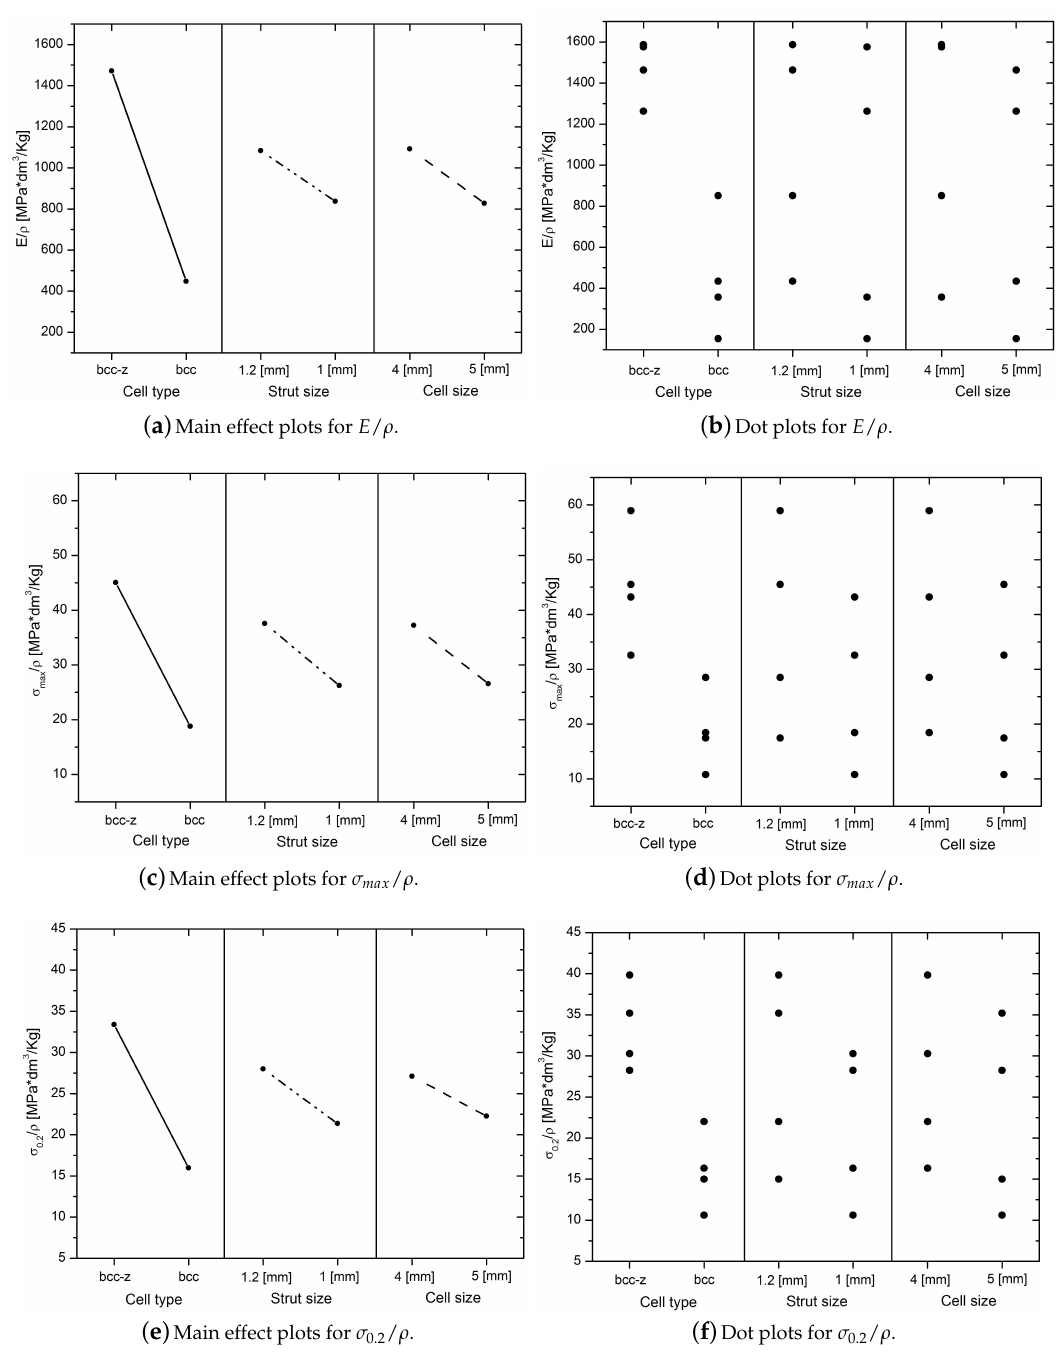
( e ) Main effect plots for σ 0.2 / ρ . Figure 4. Main effect plots and dot-plots for the specific elastic modulus, specific maximum stress, and specific stress for 0.2% of